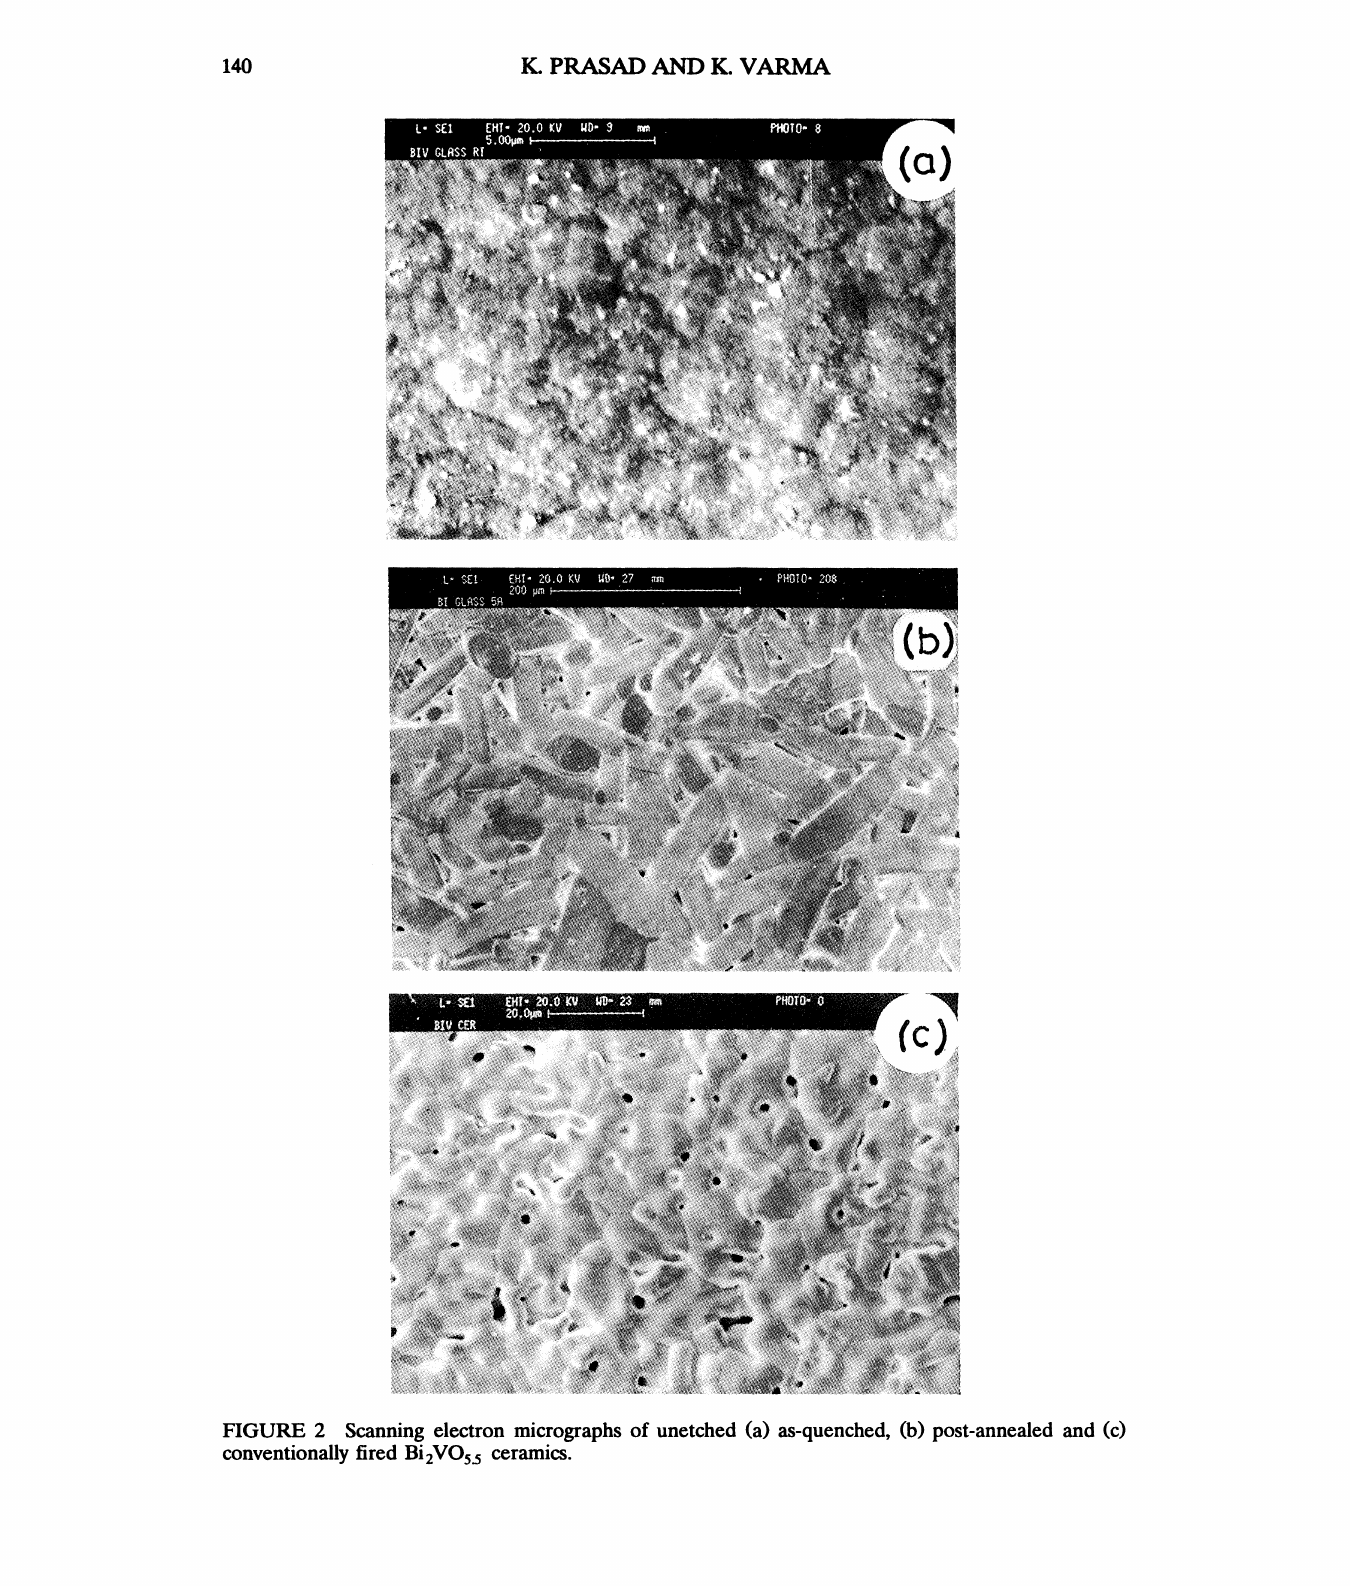
FIGURE 2 Scanning electron micrographs of unetched (a) as-quenched, (b) post-annealed and (c) conventionally fired Bi2VOs